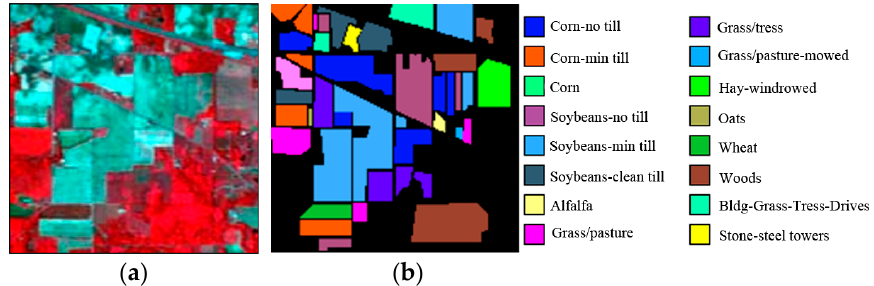
Figure 2. AVIRIS IP data: ( a ) false color RGB image RGB (50, 27, and 17); ( b ) ground truth image.